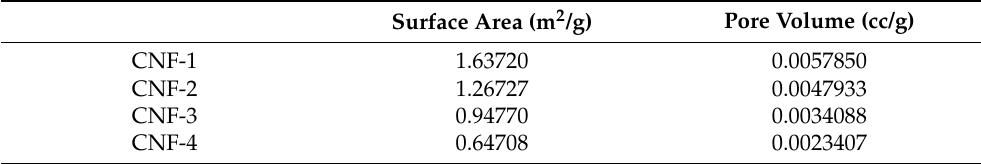
Figure 7. ( a ) BET adsorption (Ads) and desorption (Des) isotherms, ( b ) pore size distribution based on BJH analysis. Table 1. Surface area and total pore volume of CNF membranes based on BET absorption/desorption isotherm